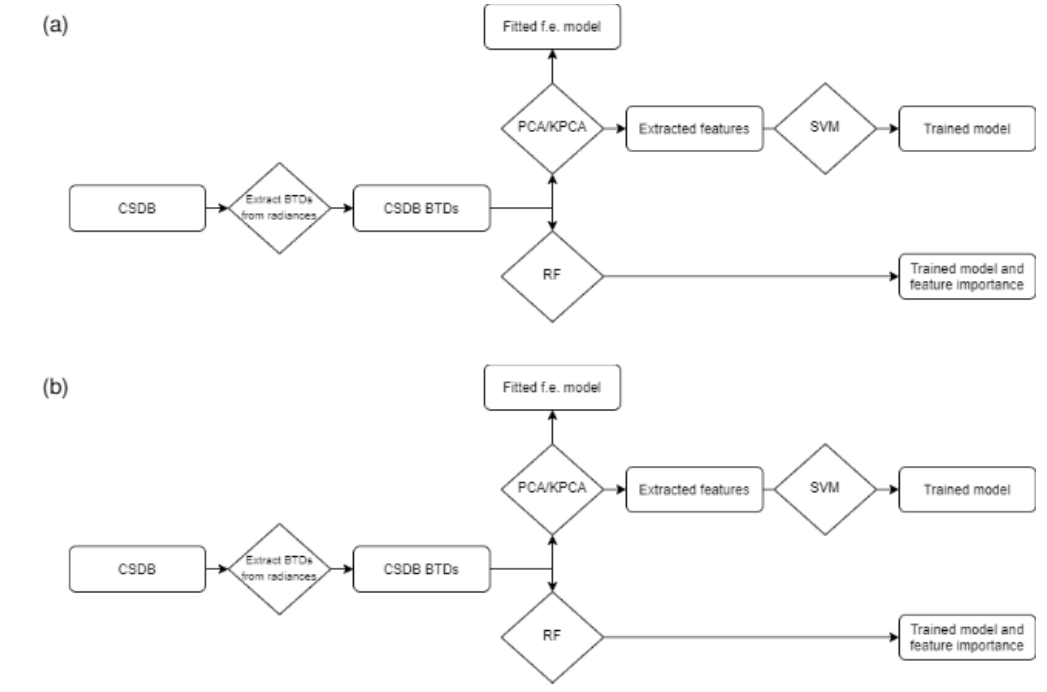
Figure 3. (a) Flowchart of the training process and (b) prediction. “F.e.” stands for feature